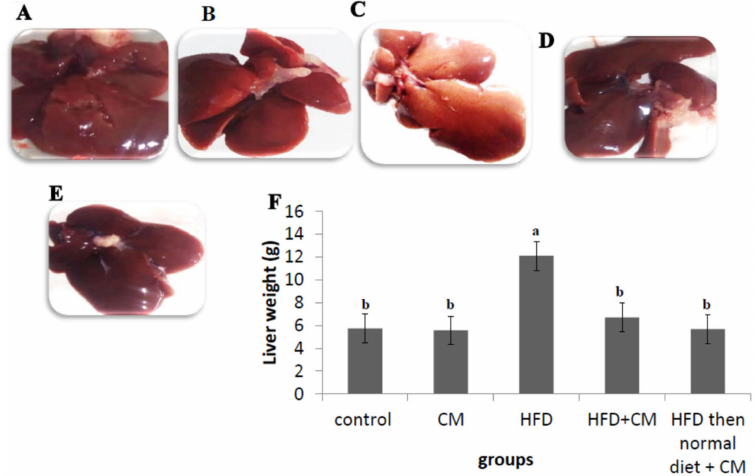
Figure 3. The e ff ect of high fat diet (HFD) and / or Commiphora myrrha resin extract (CME) on liver gross appearance and weights. Rats were reared, fed and treated as in Figure 1. Images of the gross appearance of representative livers from the di ff erent groups were shown ( A–E ). ( A , B ) showed a normal red color of livers of the control and CME rats. ( C ) showed pale yellow color with friable edges of the liver of HFD group. ( D , E ) showed normal color (dark red), smooth texture and sharp edges livers of HFD + CME and HFD then normal diet + CME groups. Livers of each rat were weighed at the end of experiment ( F ). Values presented are the mean ± SE. Columns with di ff erent letters means significant di ff erence ( p < 0.05) from the other